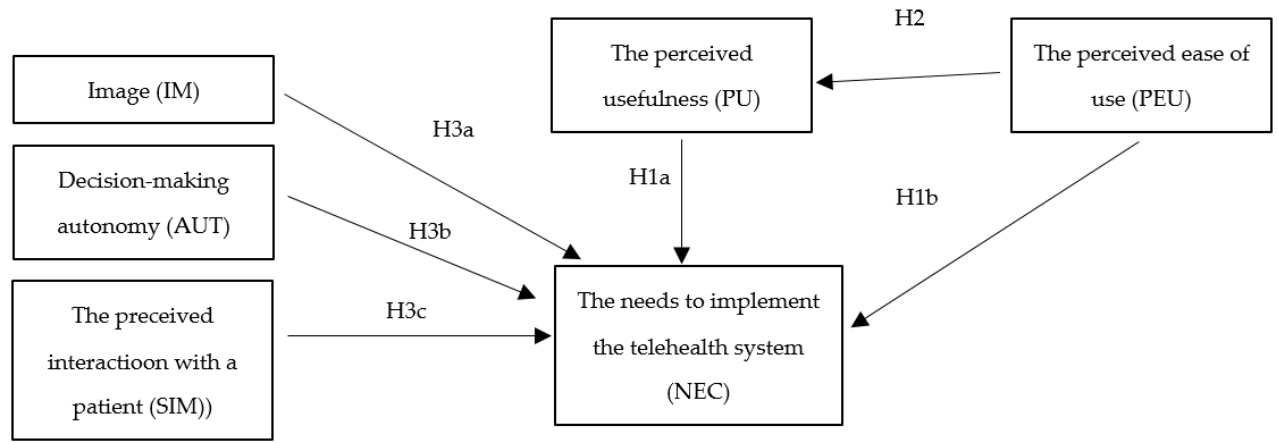
Figure 1. The theoretical model.